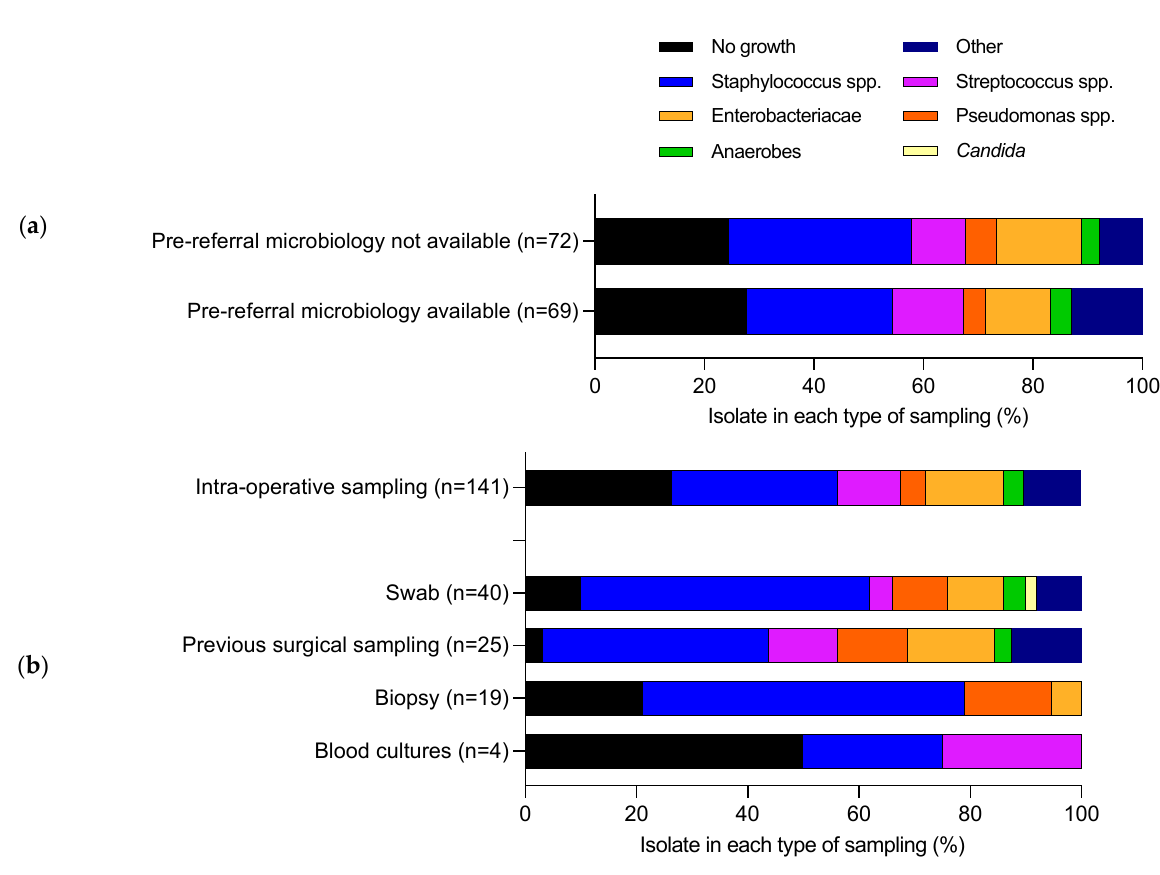
Figure 2. Comparison of the microbiology from intra-operative sampling versus microbiology from before referral. ( a ) Comparison of intra-operative sampling from patients who had pre-referral microbiology available and not available. ( b ) Distribution of each species isolated from each of the different types of sampling method that was used on pre-referral microbiology versus intra-operative sampling.